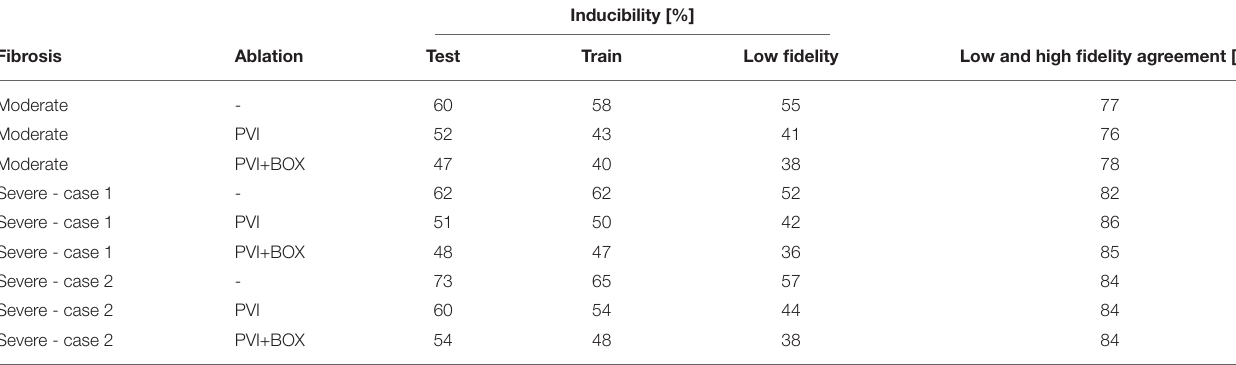
TABLE 1 | Inducibility results from the 1,800 high fidelity simulations and 900 low fidelity